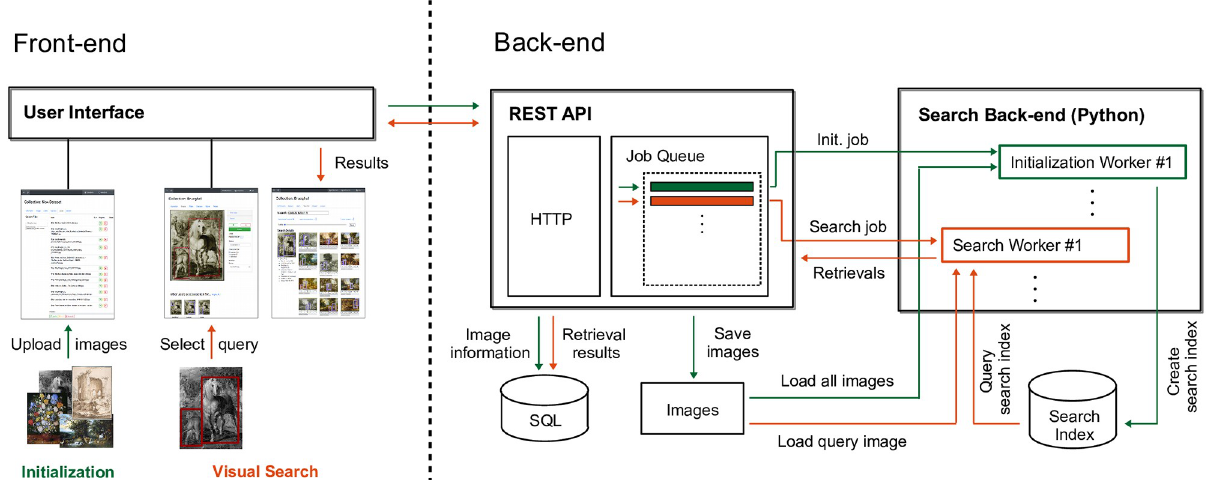
Fig 2. Overview of the interface architecture. The application is divided into a front-end and back-end, where the front-end is served as a single-page application and represents the interface for the user. The back-end consists of a REST API and the search back-end, where the search back-end consists of multiple initialization and search workers. The image material is shared by Wikimedia Commons [5] as public domain.